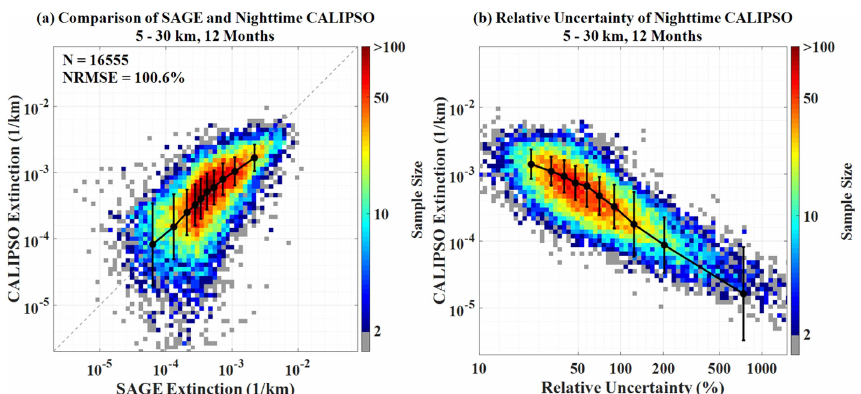
Figure 5. (a) Correlation plots of the retrieved undetected aerosol extinction between CALIPSO and SAGE III/ISS product from 5 to 30km during night-time for 12 months of validation. The colour bar represents the sample size. The black bins represent the mean values of each 10% quantile (0%–10%, 10%–20%, ..., and 90%–100%) of SAGE III/ISS 521nm aerosol extinction and corresponding CALIPSO retrieval. The I-type bars indicate the standard deviation of CALIPSO retrieval at each 10% quantile. (b) The relative uncertainty of 1 ◦ CALIPSO